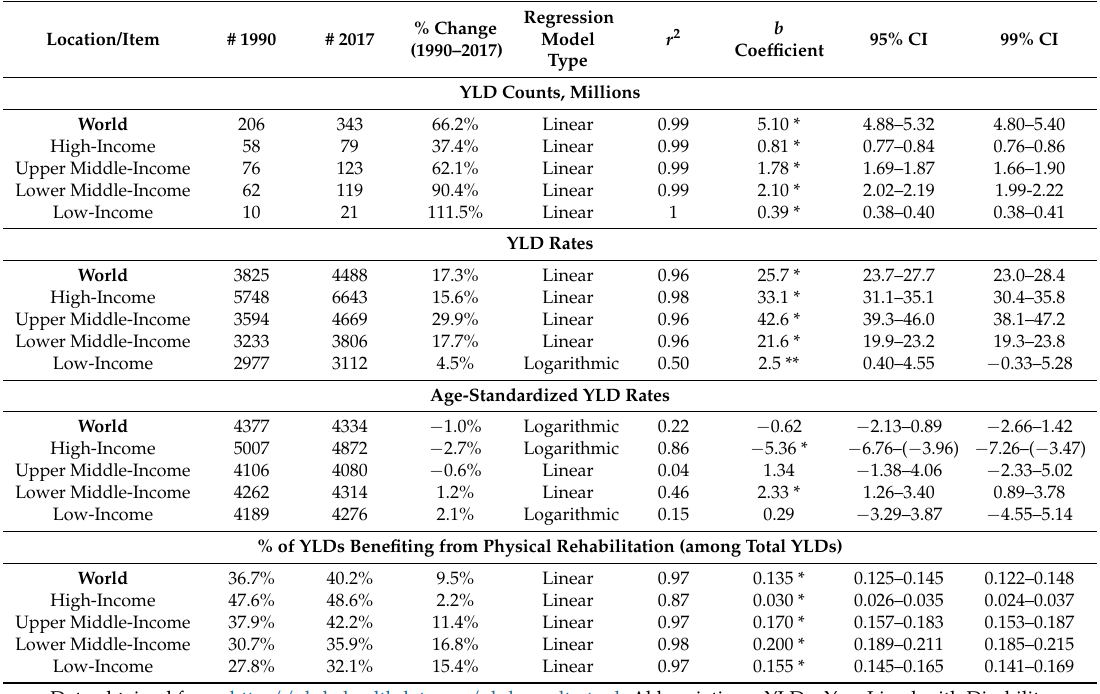
Table 3. Main analysis: YLDs from all conditions likely benefiting from Physical Rehabilitation